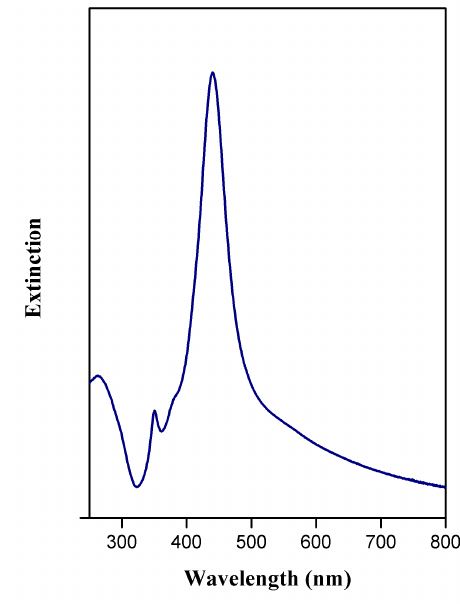
Figure 3. UV–Vis spectrum of cubic silver nanoparticles (AgCNPs).